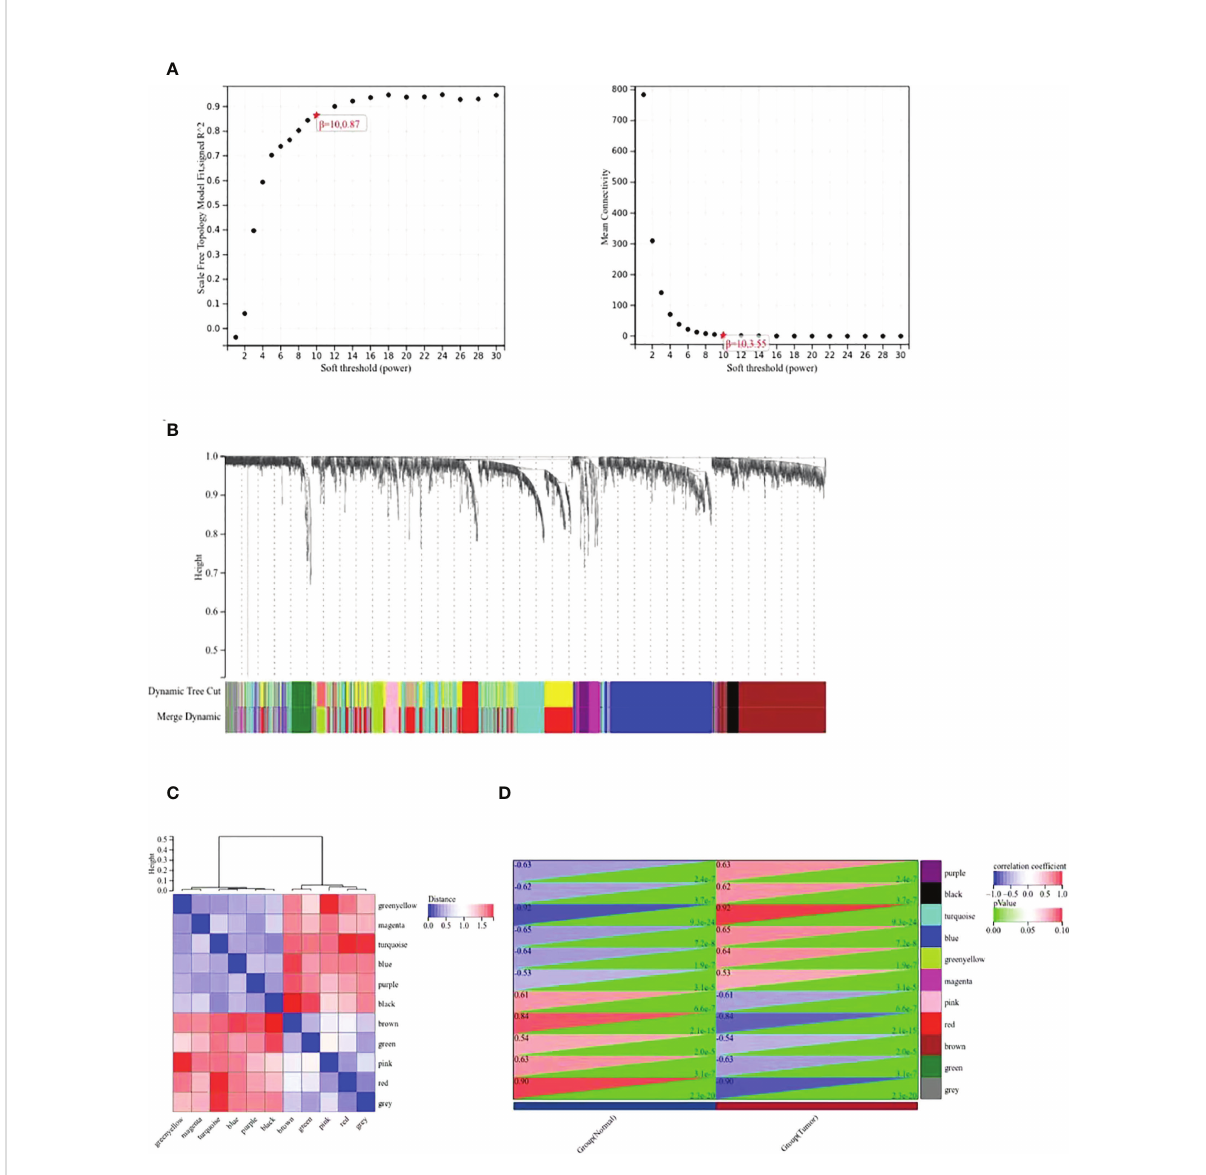
FIGURE 2 WGCNA co-expression network analysis of GSE39001. (A) Analysis of the scale-free index and the mean connectivity for various soft-threshold powers ( b ). (B) Dendrogram of all differentially expressed genes clustered based on the measurement of dissimilarity. The color band shows the results obtained from the automatic single-block analysis. (C) Modular eigenvector clustering. (D) Correlation between modules and clinical trait according to Pearson